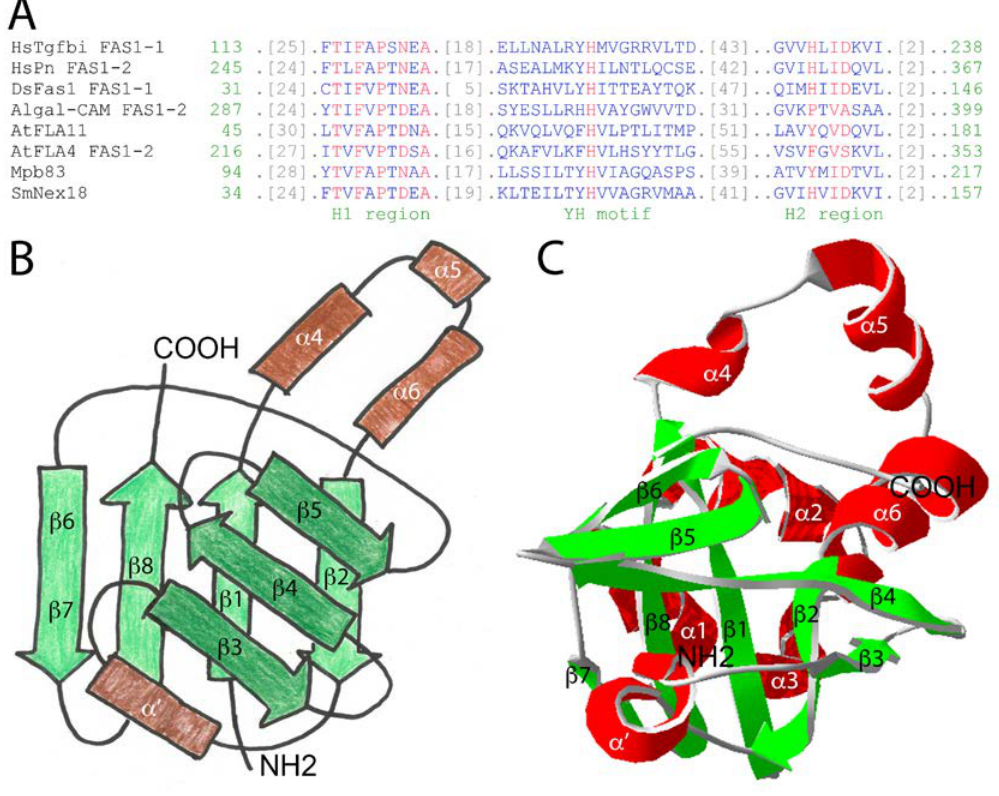
Figure 1. The FAS1 domain across kingdoms of life. ( A ) Delta-BLAST alignment of some FAS1 domains mentioned in this article. Note the conservation of the N and C-proximal H1 and the H2 region as well as the central YH motif. The sequences used by Delta-BLAST were HsTgfbi (NP_000349.1), HsPn ( gi 93138709 ), DsFas1 FAS1-3 ( 1O70_A ), Algal-CAM ( gi 75282282 ), AtFLA11 ( gi 116247778 ), AtFLA4 ( gi 75206907 ), MbMpb83 ( gi 614094354 ), and SmNex18 ( gi 81635876 ). Red/blue indicates highly/not conserved residues; color bits threshold set to 2.5; ( B ) The general topology of the FAS1 domain features is reminiscent of the “thumbs-up” gesture. The secondary structure of HsTgfbi FAS1-1 is annotated omitting the three N-terminal helices for clarity; ( C ) The crystal structure of HsTgfbi FAS1-1 [33] in ribbon display.